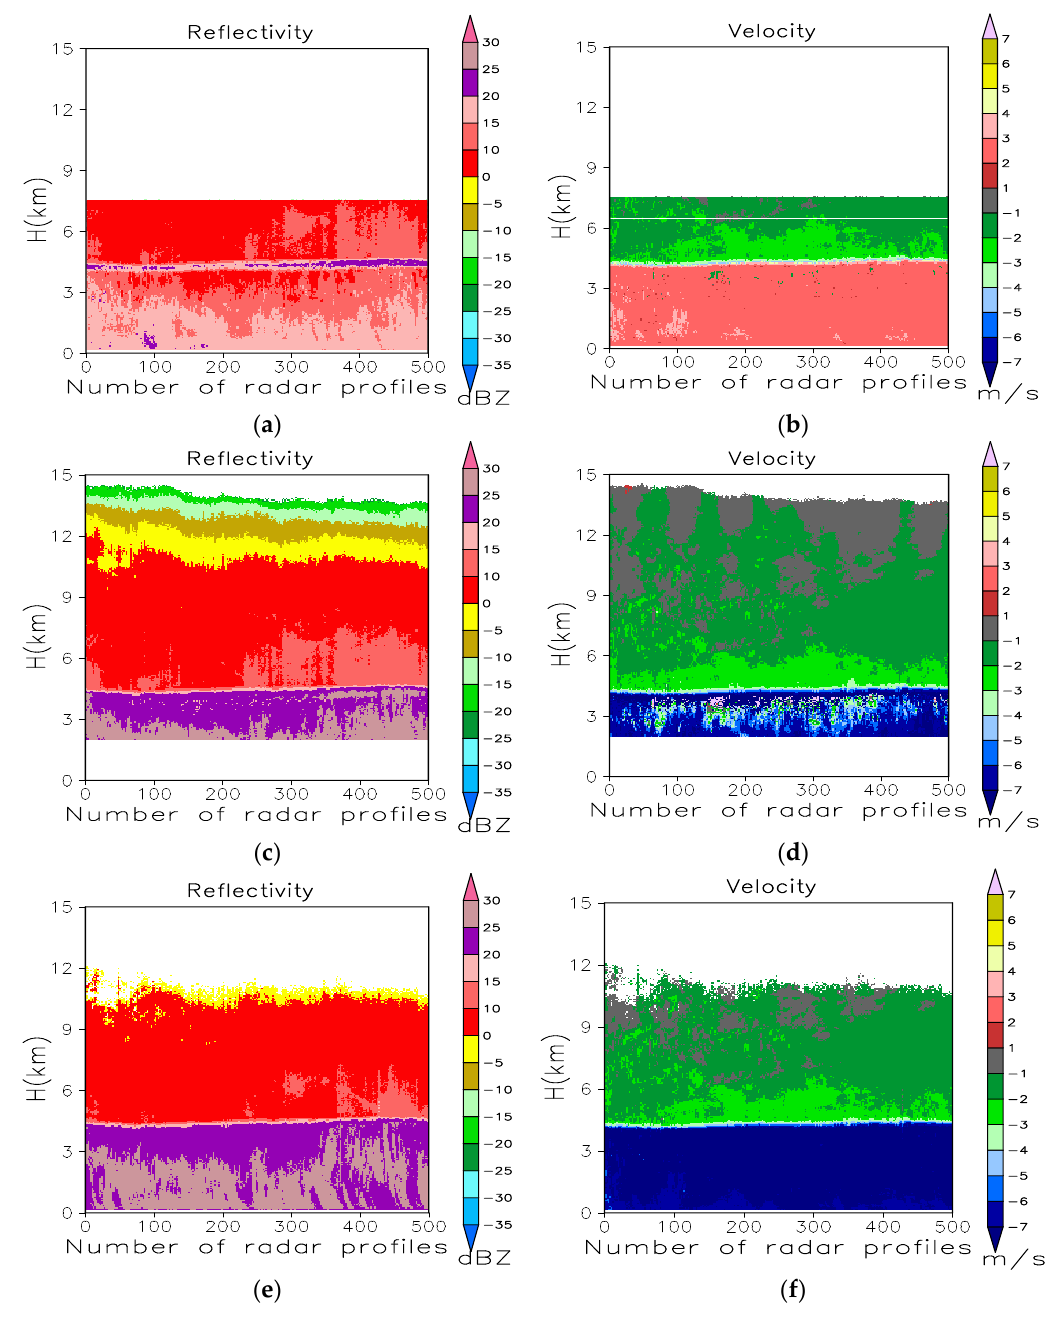
Figure 1. Time–height cross-sections of raw reflectivity and radial velocity measurements from ( a , b ) M1, ( c , d ) M2, and ( e , f ) M3 for 500 radar profiles for the period between 4:07 p.m. and 5:21 p.m. Beijing time (BT) on 4 June 2016. The height is given above ground level. The reflectivity below 4.5 km is underestimated by M1 in ( a ), while the velocities in ( b ) and ( d ) are aliased.